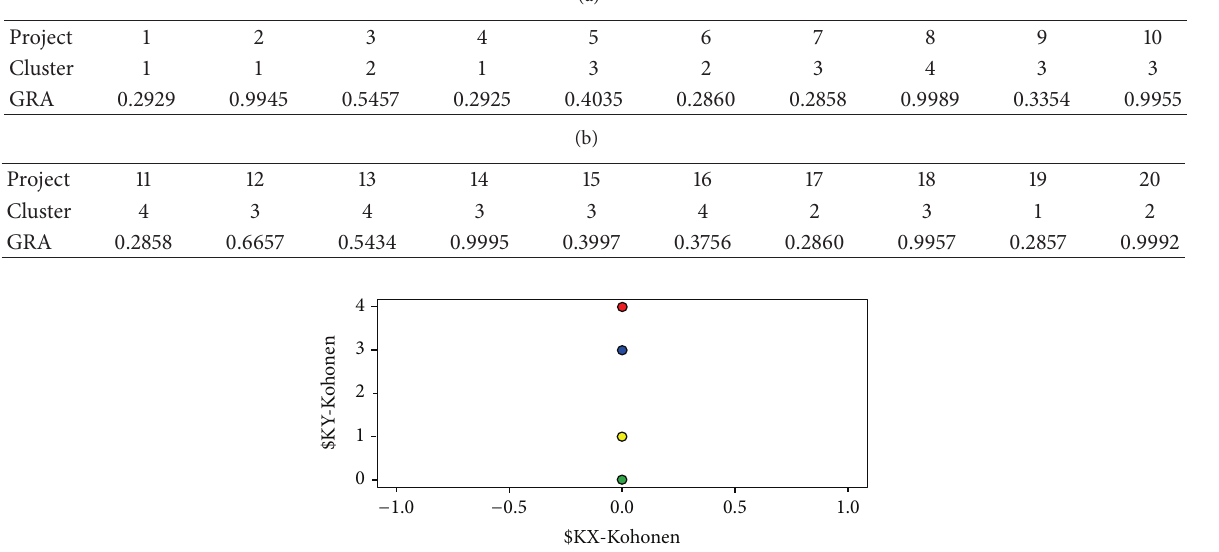
Table 5: The results from ranking the projects in each cluster with grey relational analysis. (a)